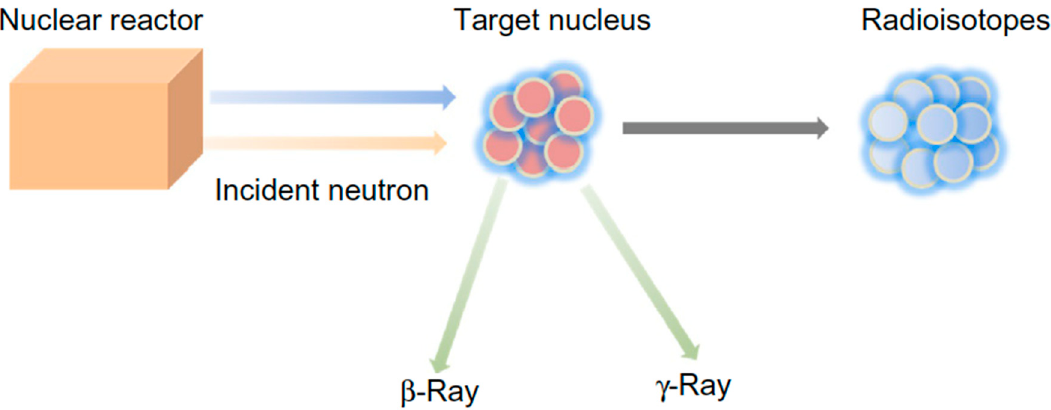
Figure 3. Schematic representation of nuclear reaction between a target nucleus and an incident neutron, leading to the formation of a radioisotope and the emission of beta and/or gamma rays. Figure reproduced from Deliberato Aspasio et al. [27].